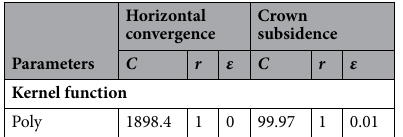
Table 6. Optimal parameters of the best SVR